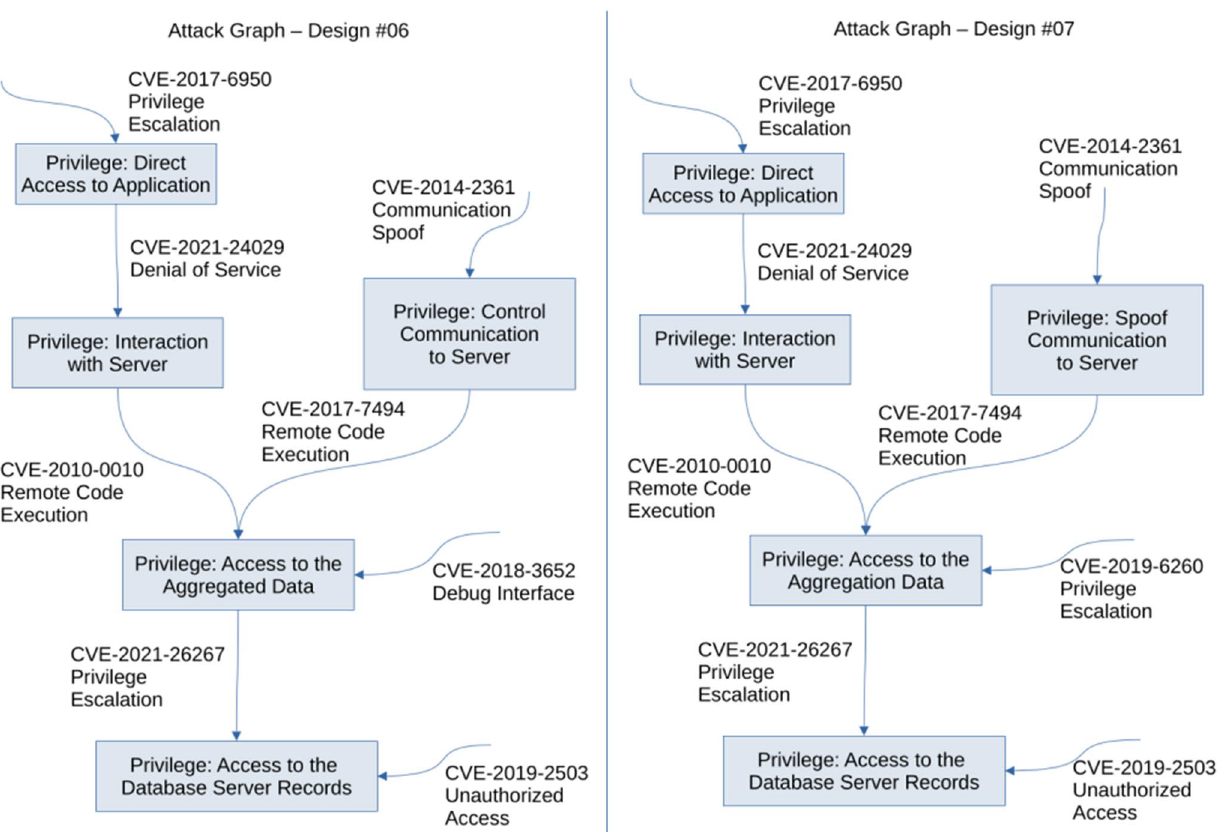
Fig. 10 Illustration of the attack trees for IoT home design 06 & 07